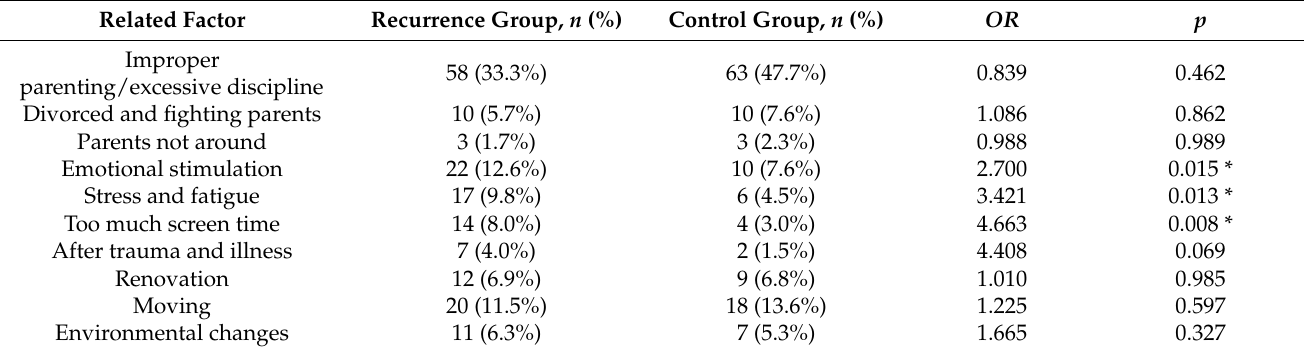
Table 5. Relationship between psychosocial and environmental factors and tic recurrence (modifiable